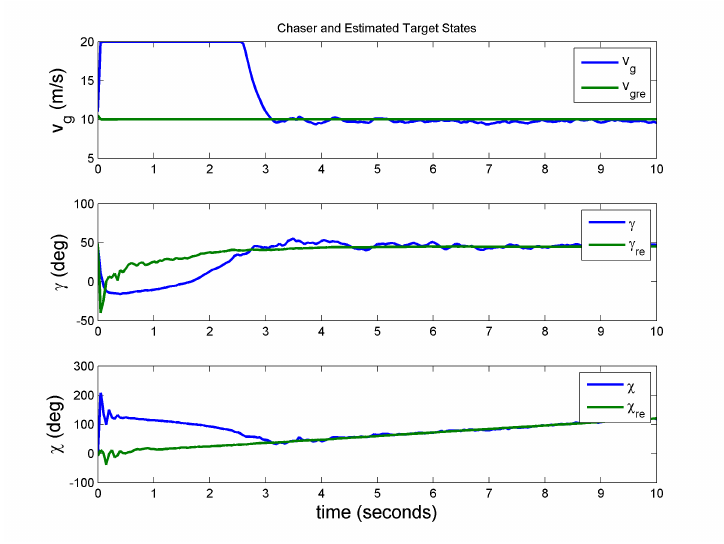
Figure 15. Speed, flight path angle, and heading angle tracking (Case 1C).